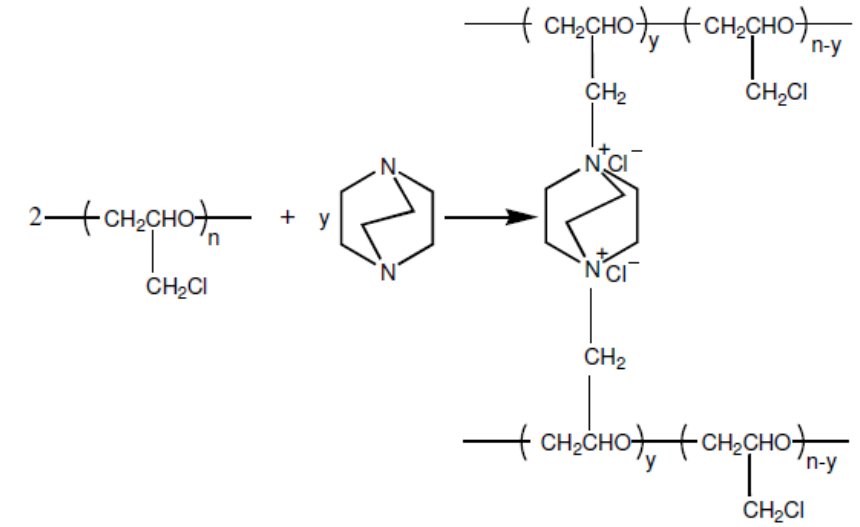
Figure 3. Reaction mechanism of amination-crosslinking of PECH polymers [12].